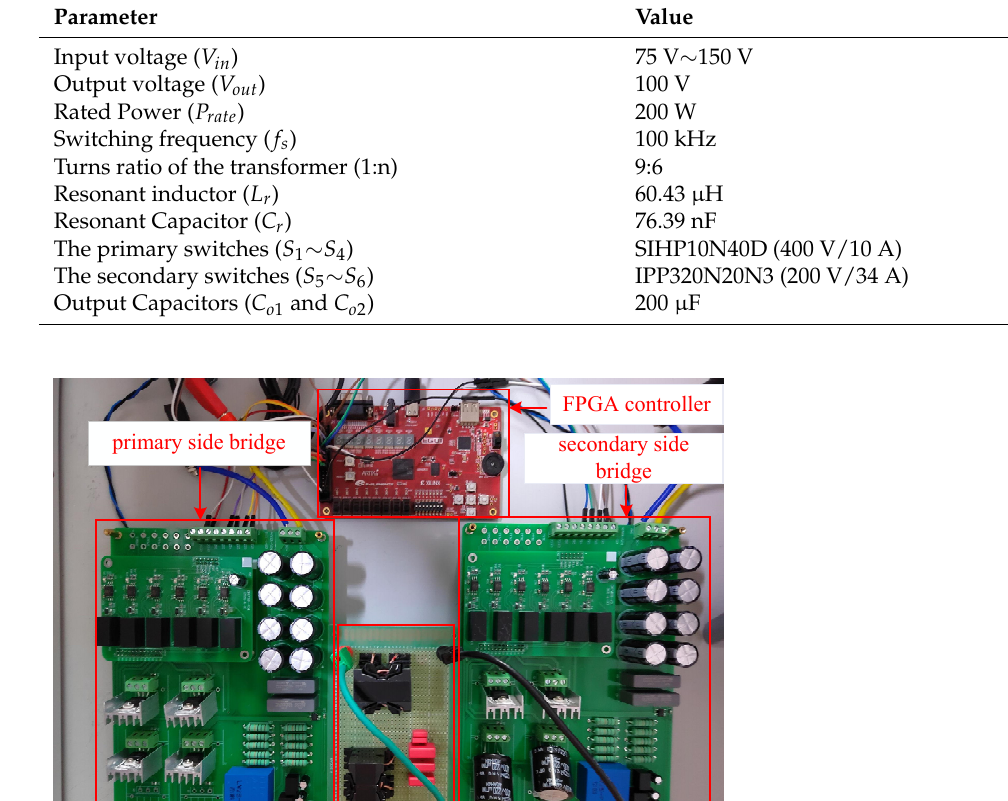
Table 3. Parameters of the Experiment.